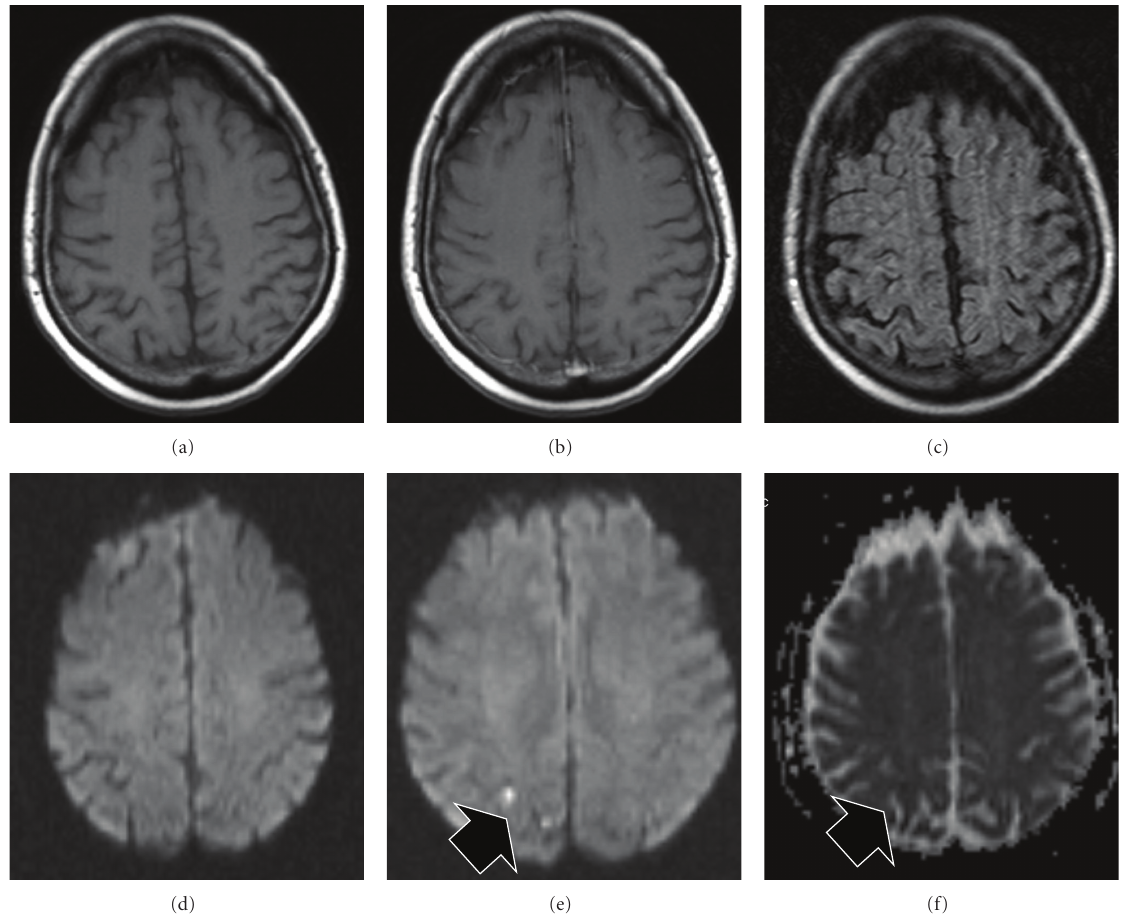
Figure 2: MRI obtained 32 hours after patient’s symptoms onset. Top row: T1WI before contrast (a), T1WI after contrast (b), FLAIR-T2 images (c) are unremarkable. On the bottom row, DWI ((d)-(e)) and the corresponding ADC map (f) show two tiny foci of restricted water di ff usivity in the right parietal lobe, indicating acute lacunar